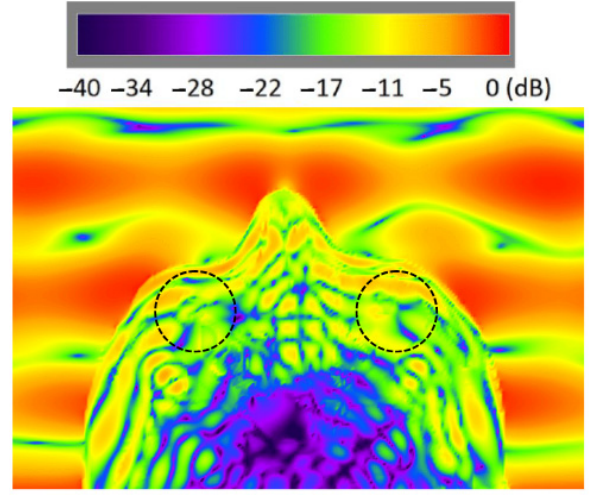
Figure 13. Power density distribution without shield (vertical polarization); reference value 0 dB = 40 W/m 2 . The regions in the circle are the areas of the eye.